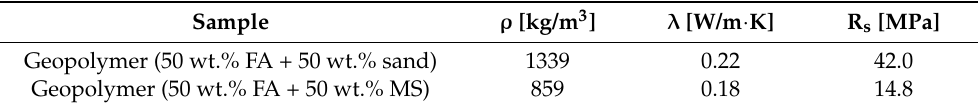
Table 4. Selected properties of geopolymer matrices.